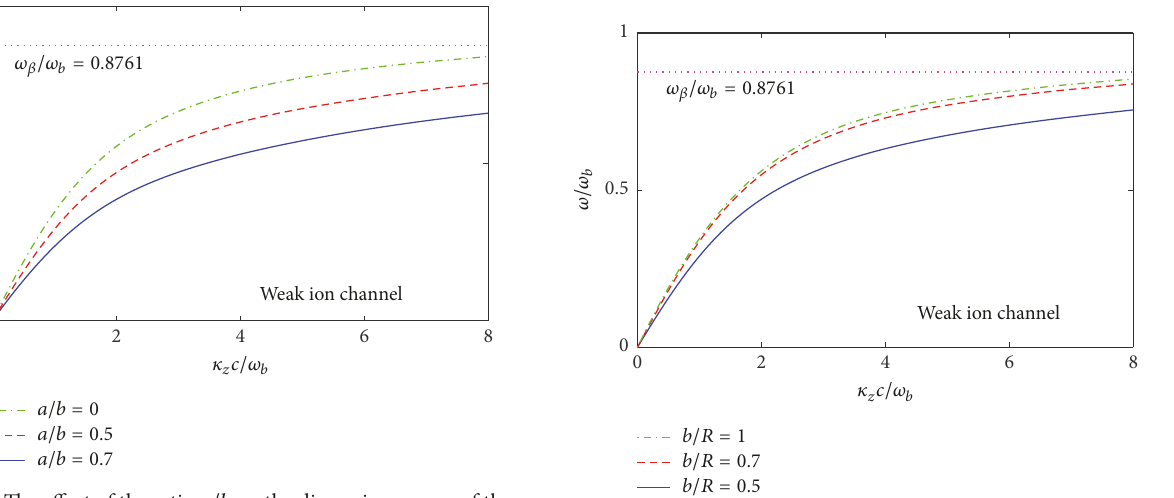
Figure 9: The effect of the ratio 𝑏/𝑅 on the dispersion curves of the Be 01 modes for weak ion channel with 𝜔 𝛽 = 0.8761 . The inner radius of the annular beam is taken as 0.25 R . 𝑏/𝑅 = 1 represents the waveguide completely filled with the annular